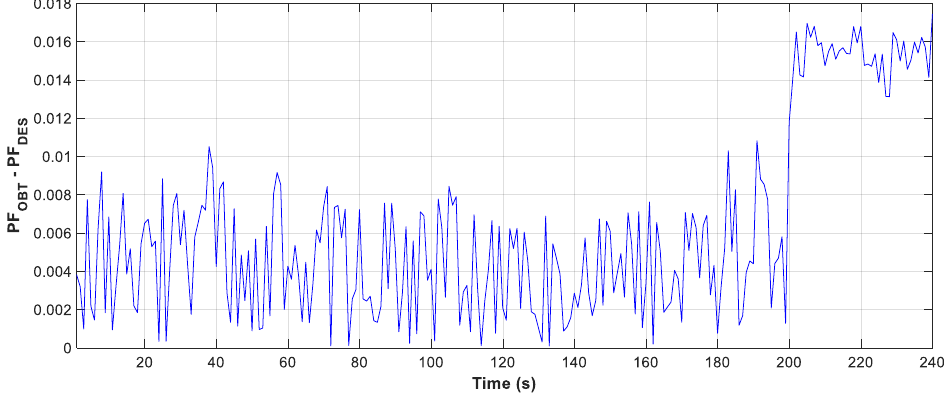
Figure 12. Difference between PF OBT and PF DES (1-phase motor). Figure 12. Di ff erence between PF OBT and PF DES (1-phase